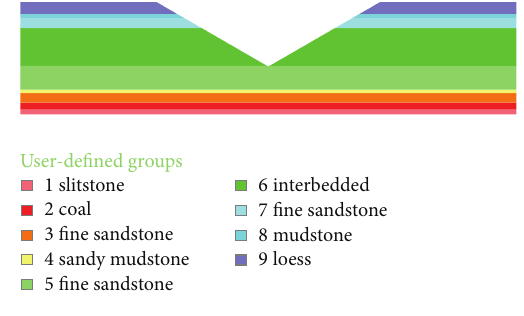
Figure 7: The model for FLAC